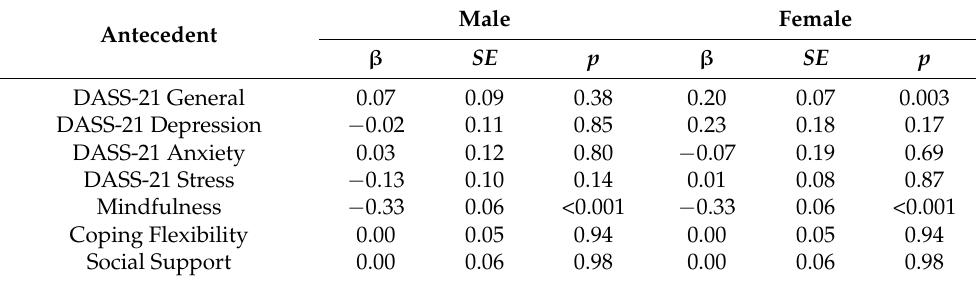
Table 3. Latent multiple regression of IGD tendency across two countries (Model 9).